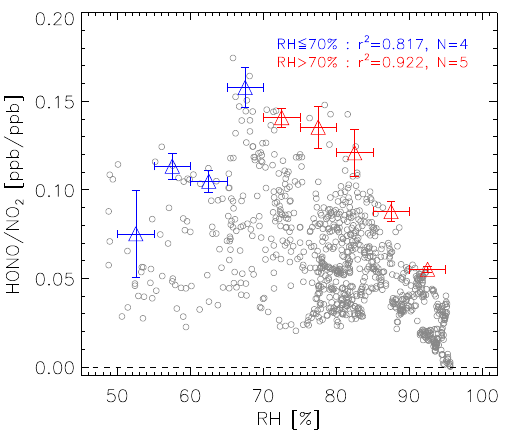
Fig. 7. Scatter plot of HONO / NO 2 against RH in the time inter- val of 18:00–00:00LT (time interval avoids influence of OH+NO, see Fig.5). Triangles are the averaged top-5 HONO / NO 2 in each 5% RH